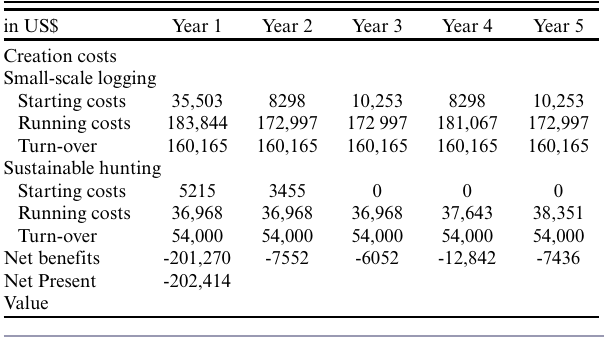
Table 3 . Financial cost-benefit analysis for the Uma local community forest concession.